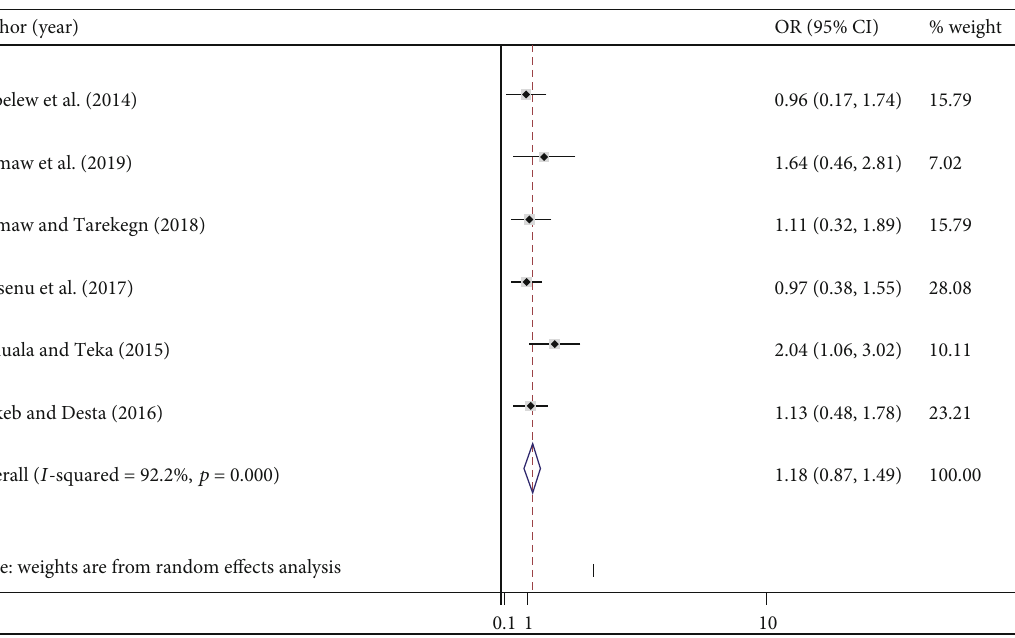
Figure 6: The pooled odds ratio of the association between RDS and neonatal mortality.